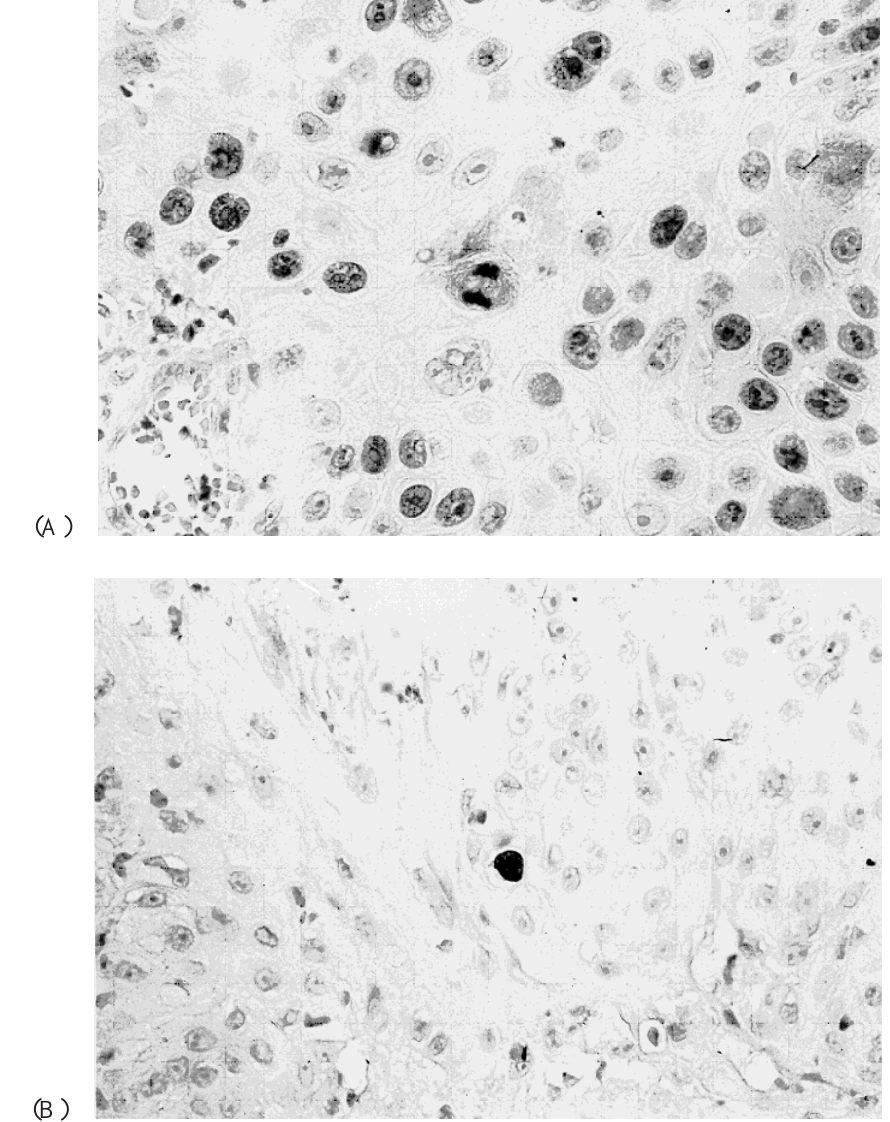
Fig. 1. Cellular proliferation and apoptosis in a poorly differentiated laryngeal carcinoma. (A) In this poorly differentiated carcinoma a high level of proliferation can be observed, measured by positive Ki-67 labelling. (B) The same tumour reveals comparably lower degree of apoptosis. The apoptotic figures are randomly distributed over the tumour. (Magnification ×